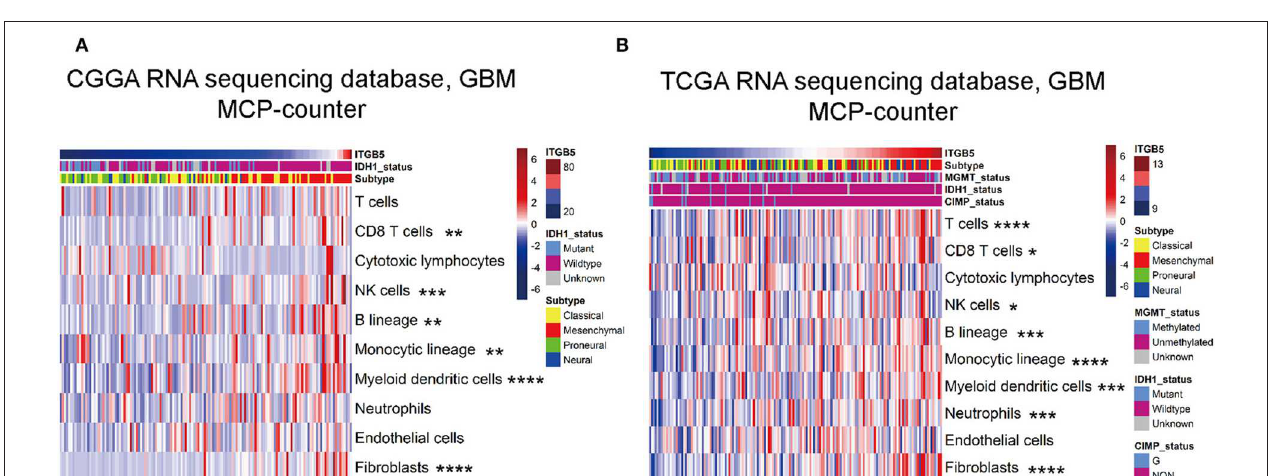
FIGURE 5 | or siNC. (B) The effect of ITGB5 silencing on the growth of LN229 and PGC1228 cells. (C) ITGB5 knockdown suppresses tube formation by endothelial cells treated with conditioned medium from cultured glioma cells. (D) Glioma cell migration (upper panel) and invasion (lower panel) are inhibited by ITGB5 knockdown. (E) Western blot analysis of glioma cells transfected with indicated siRNAs showing that ITGB5 silencing attenuates MMP2 and MMP9 expression. (F) GSEA of CGGA and TCGA RNAseq datasets reveals the enrichment of epithelial–mesenchymal transition-related genes in specimens with high ITGB5 levels. (G) Western blot analysis